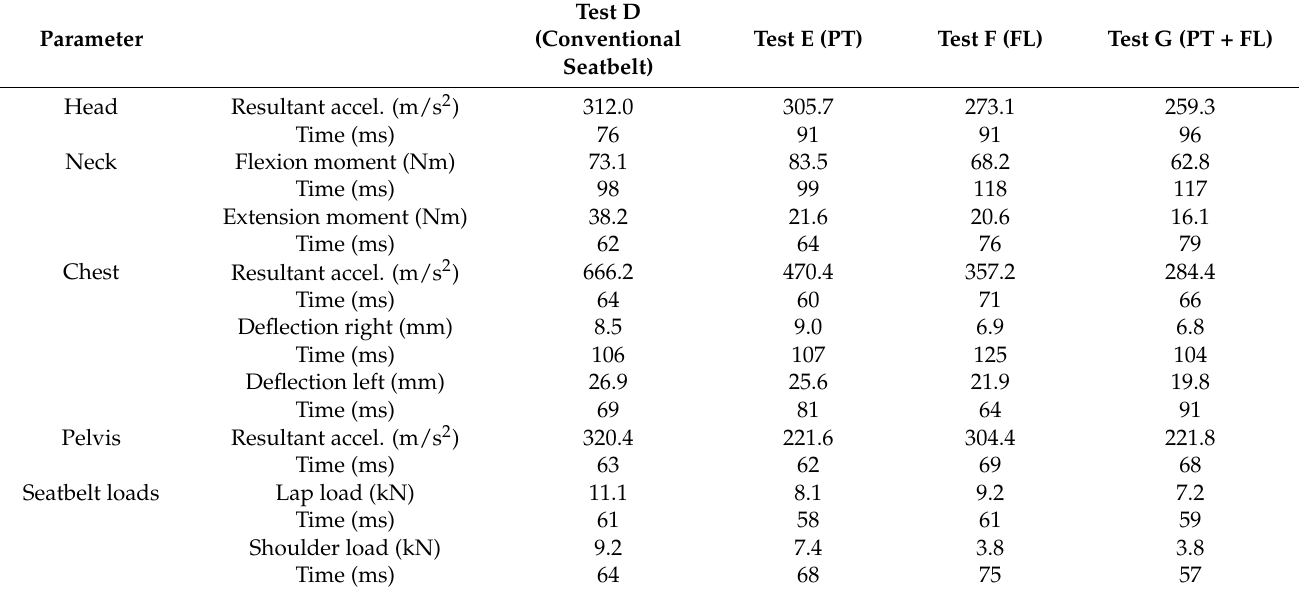
Table 2. Average maximum head, chest, and pelvis accelerations, as well as neck flexion, extension moments, chest deflections, and seatbelt loads, using a correctly positioned conventional seatbelt (Figure 1), equipped with neither pretensioner nor force limiter (Test D), a pretensioner only (Test